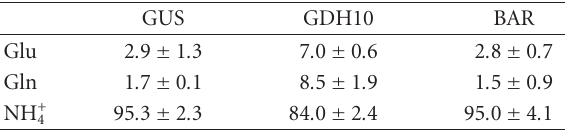
Table 4. Labeling of the glutamate pool via absorption of 13 NH + 4 in entire leaves of transgenic plants treated with 1mM MSX for 1.5 hours before feeding. Leaf petioles were recut under water. Tracer exposure was for 15 minutes. Incorporation is expressed as a percentage of the label input plus or minus the range de- tected among 3 individual plant replicates and three measure- ment